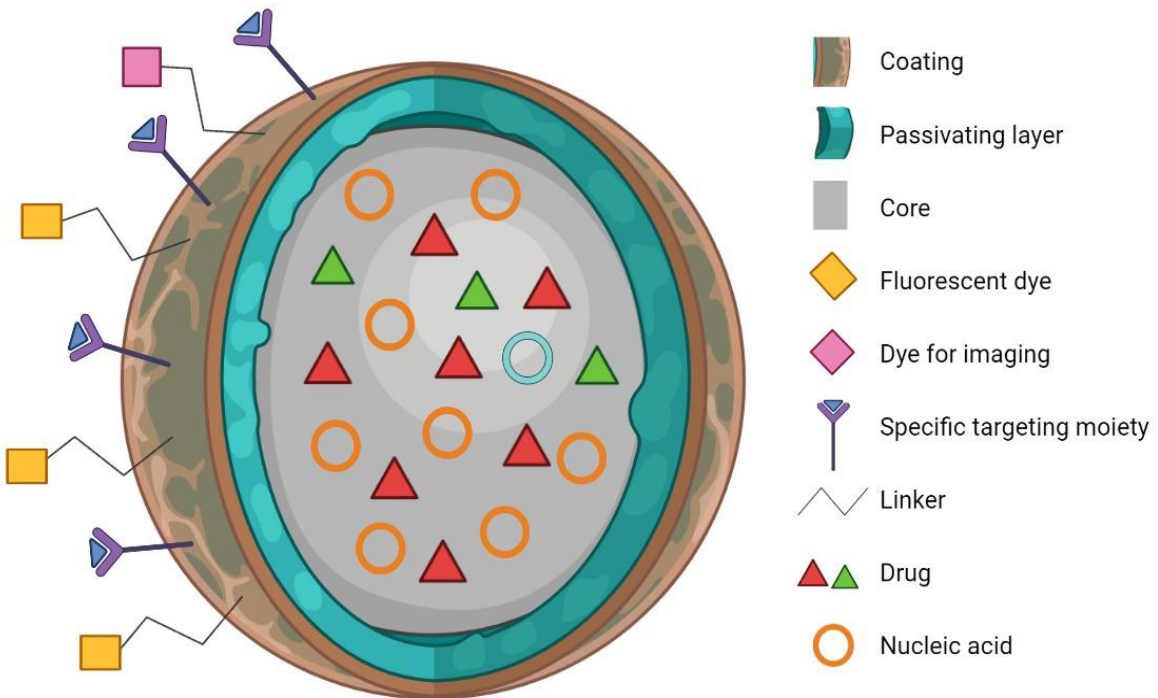
Figure 8. Schematic representation of multifunctional NPs that may include an imaging component, a targeting element, and a therapeutic constituent.